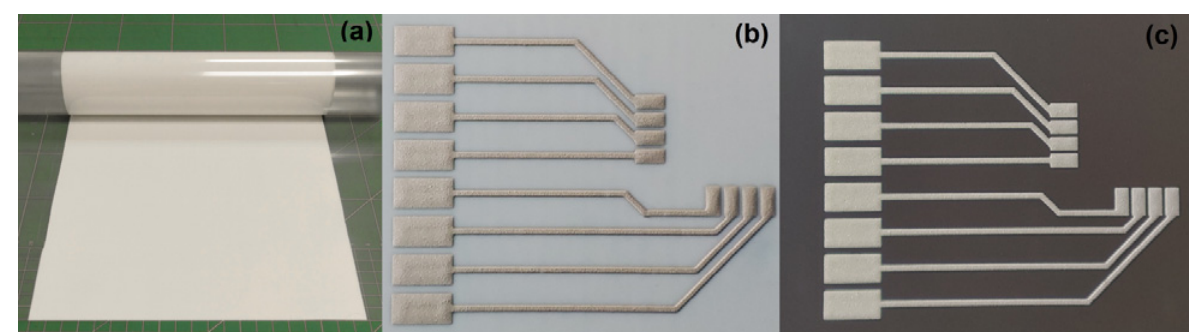
Fig. 4 Surface roughness of Li 2 WO 4 green tape determined using a optical profilometer.